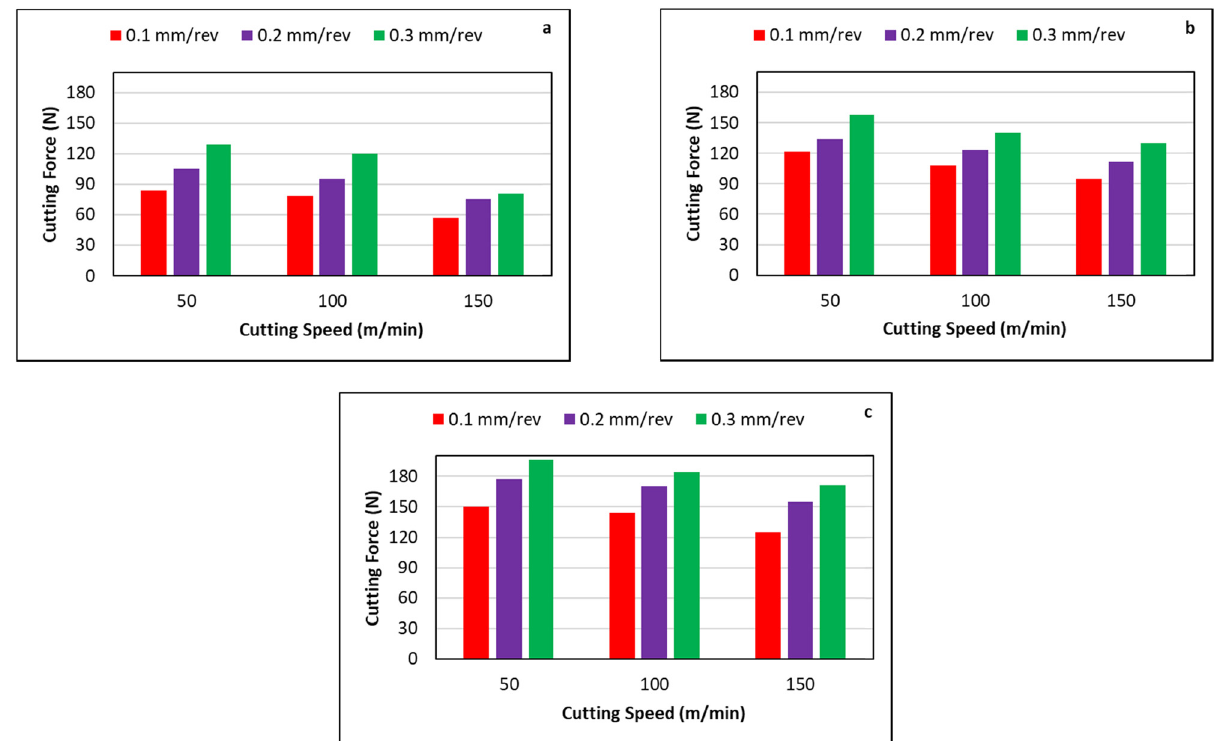
Figure 6: In fl uence of cutting speed on cutting force at constant depth of cut 2 mm: ( a ) fi ber orientation 30°, ( b ) fi ber orientation 60°, and ( c ) fi ber orientation